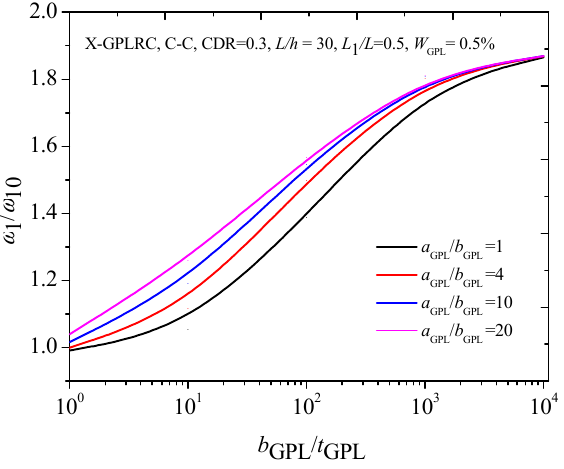
Figure 5. E ff ect of GPL geometry on fundamental frequency of C-C cracked FG-X-GPLRC beam. Figure 5. Effect of GPL geometry on fundamental frequency of C-C cracked FG-X-GPLRC beam.